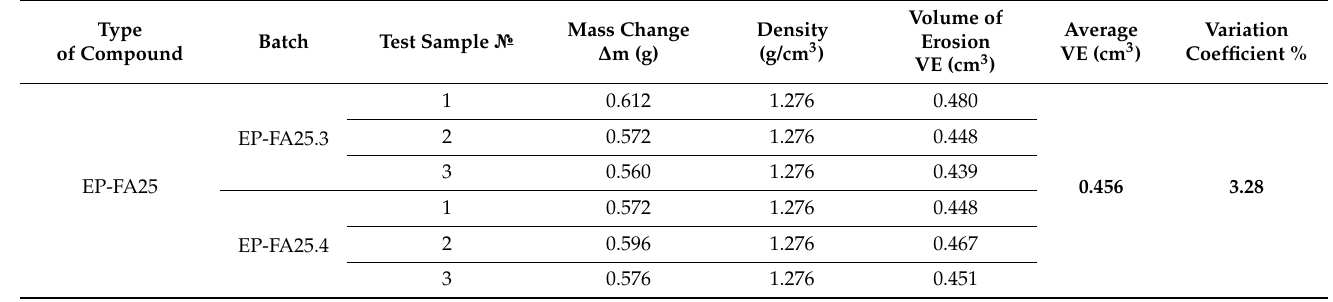
Table A12. Wear of filled epoxy binder (EP-FA25) at 180 ◦ C at an impingement angle of 45 ◦ .